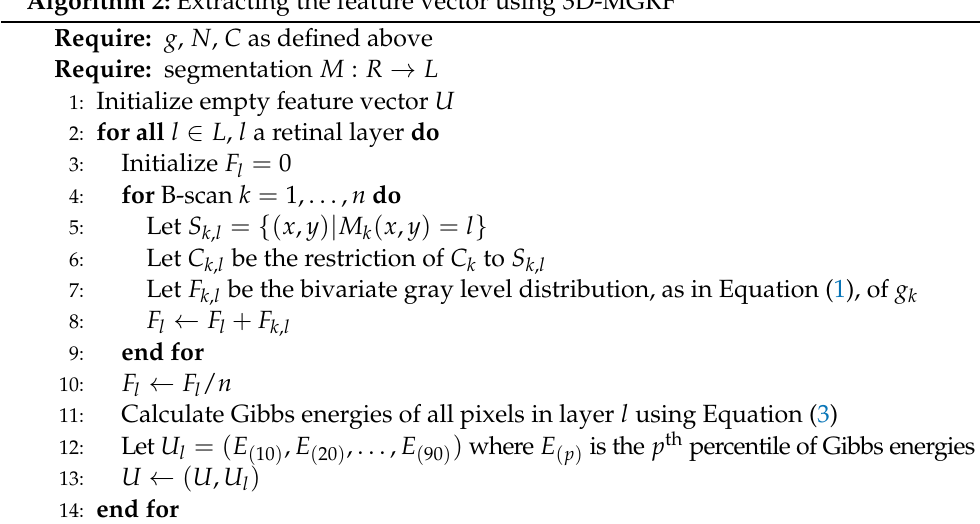
Algorithm 2: Extracting the feature vector using